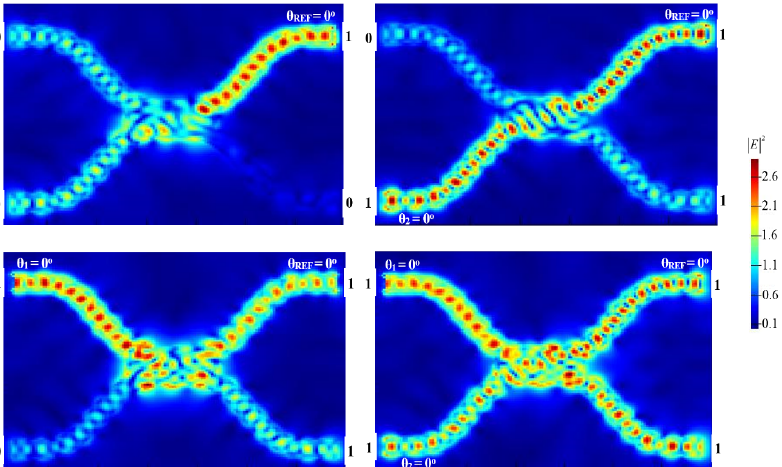
Figure 10. Light field distributions for OR function utilizing 2 × 2 silicon waveguide at 1.55 μ m.